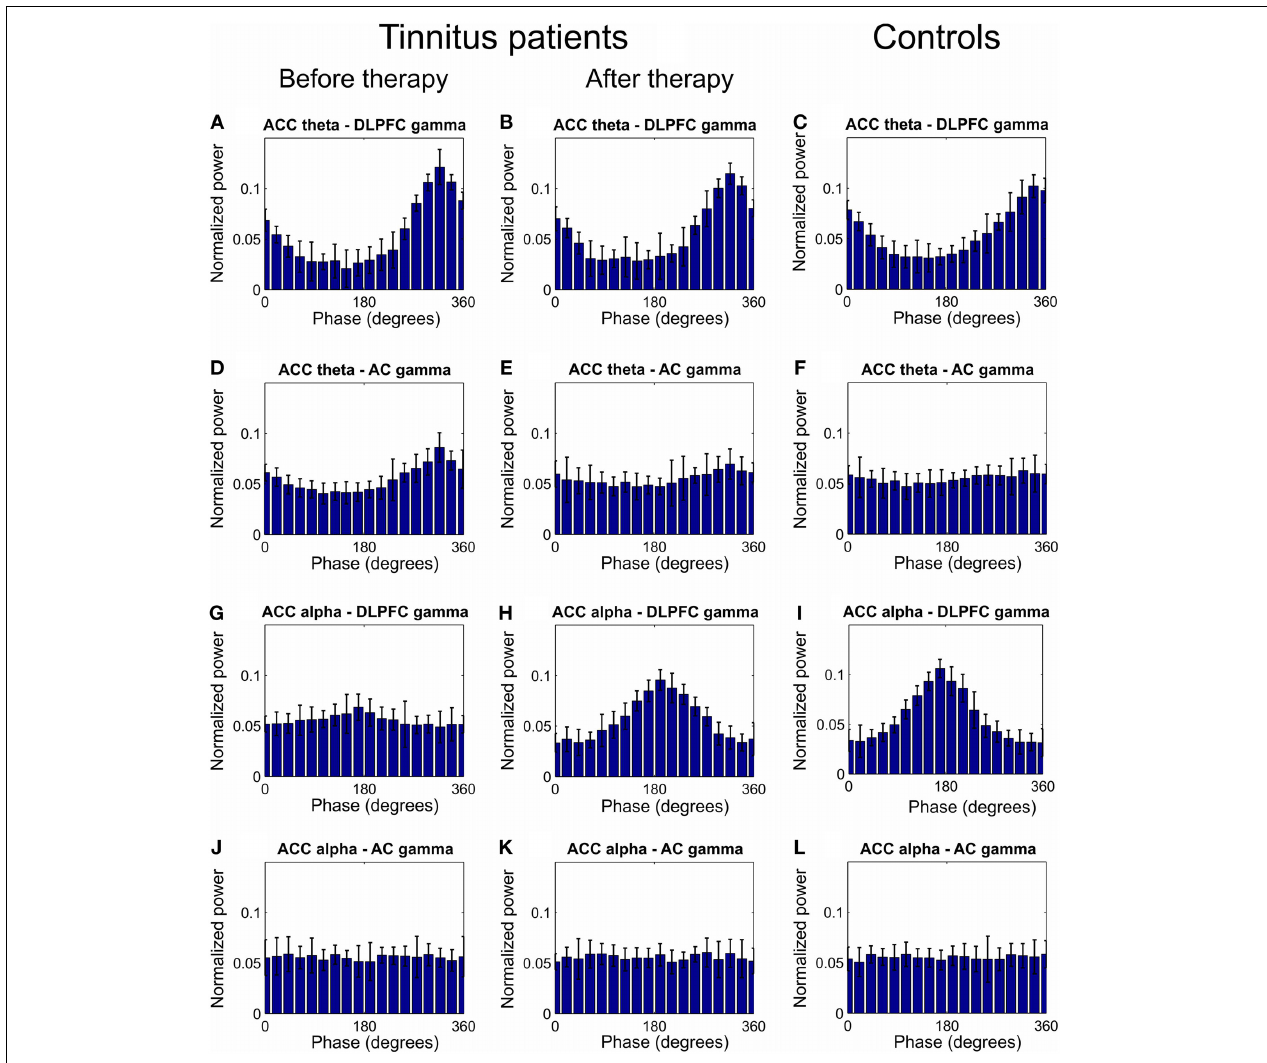
FIGURE 3 | Grand average of the distribution of gamma power across all ACC theta and alpha phases. (A–C) Distribution of DLPFC gamma power across all theta phases of ACC theta at baseline (A) and at 12 weeks visit (B) in tinnitus patients and in tinnitus free controls (C) . (D–F) Distribution of AC gamma power across all theta phases of ACC theta at baseline (D) and at 12 weeks visit (E) in